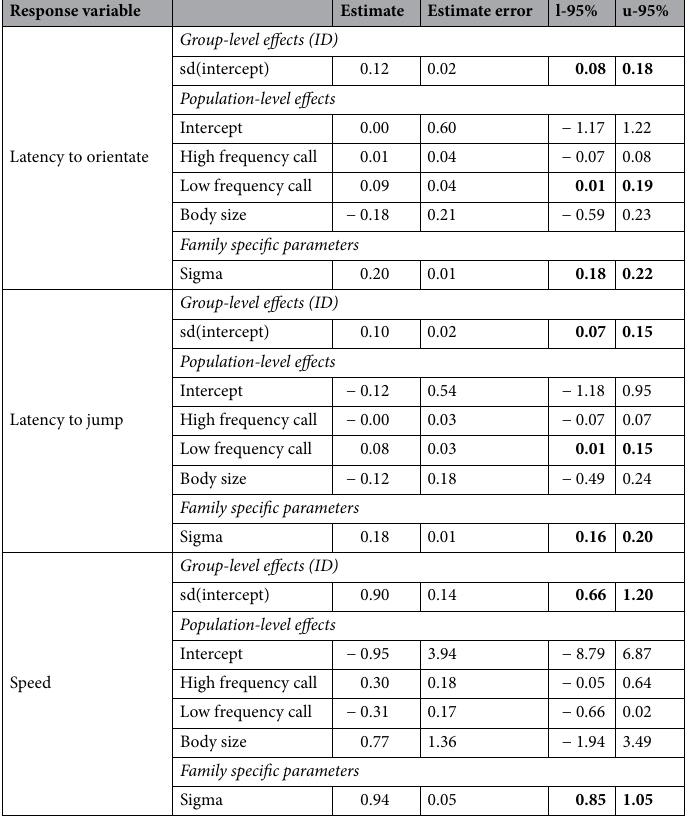
Table 1. Results of the Bayesian random regression models fitted with a random intercept (for the individual). Estimates and credible intervals (l-95% and u-95%) are presented. A constant transformation has been applied on the three response variables. Significant credible intervals (i.e., non-overlapping zero) are written in